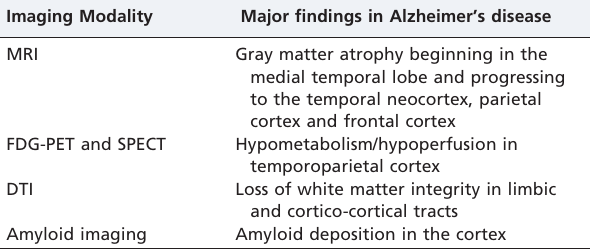
Table 2 - Clinically relevant neuroimaging findings in patients with Alzheimer’s